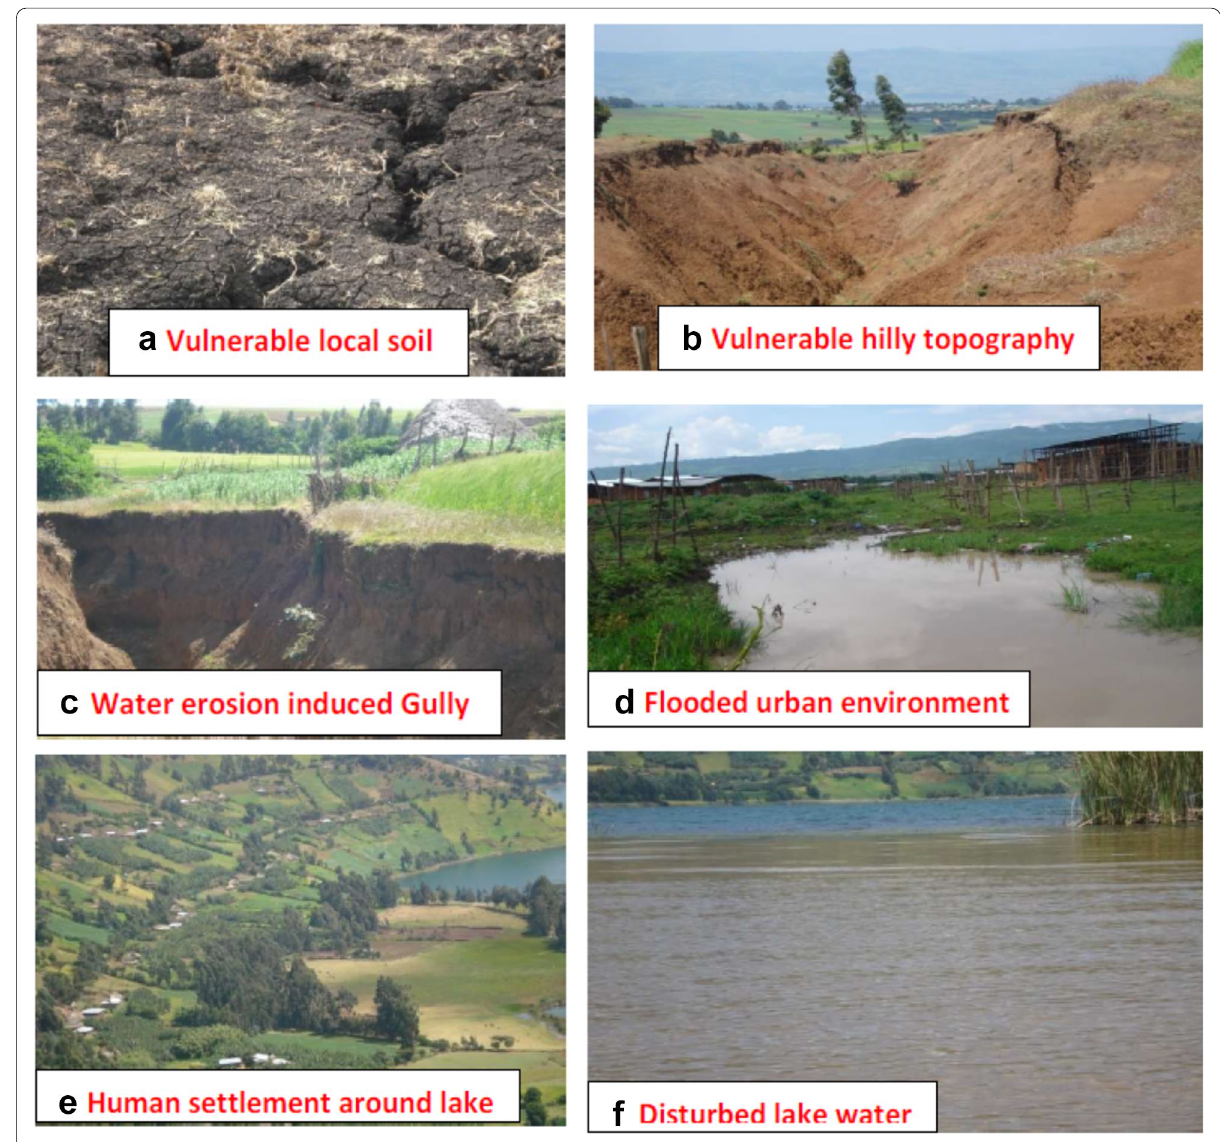
Fig. 6 Partial view of drivers of land use and land cover changes in Huluka watershed: a vulnerable local soil, b Vulnerable hilly topography, c Water erosion induced gully, d Flooded urban environment, e Human settlement around the lake, and f Disturbed lake water ( Source: Participant Observation